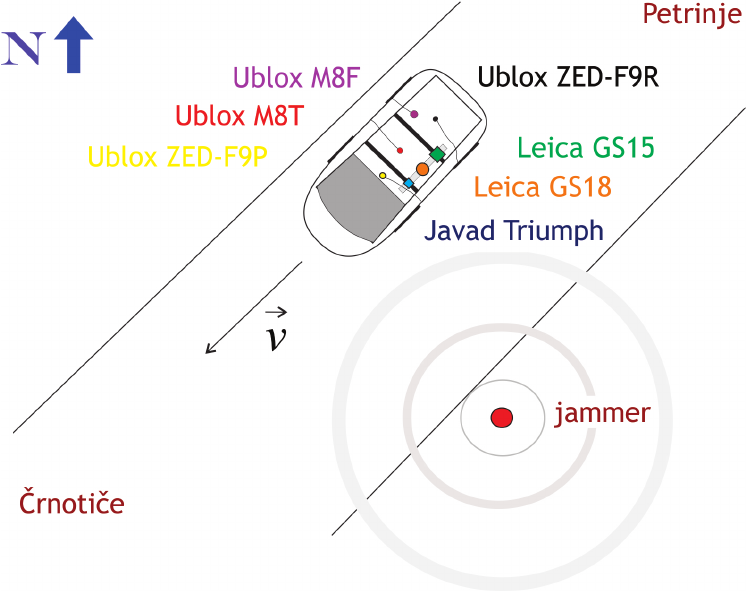
Figure 3. Vehicle with the GNSS receivers on the roof passing by the road static jammer (own study).